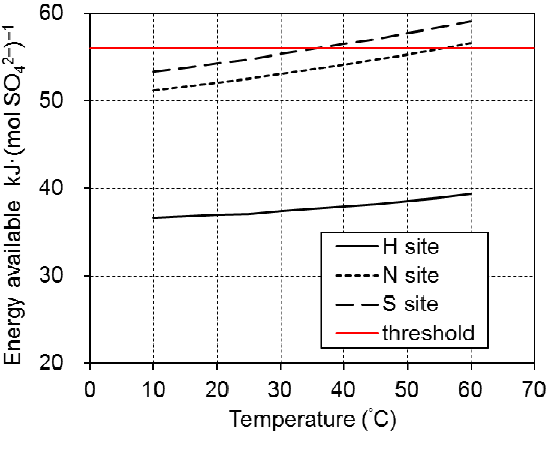
Figure 3. Calculated thermodynamic energy available via microbial sulfate reduction using acetate as an electron